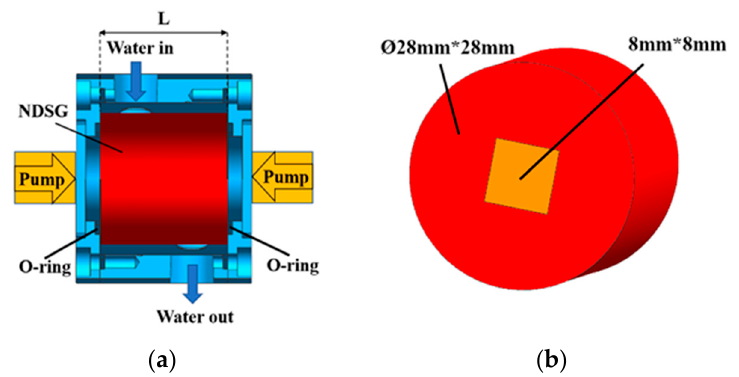
Figure 3. ( a ) Structure of the amplifier head, ( b ) NDSG rod and pump spot.